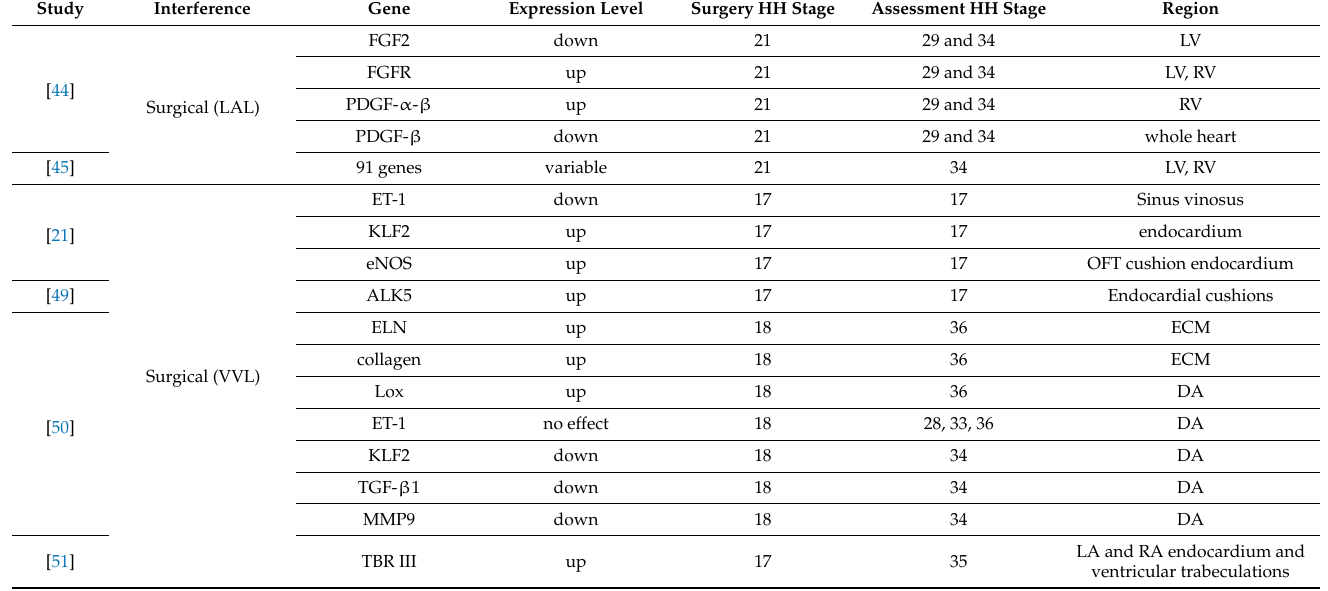
Table 1. Summary of surgical interventions and the genes they up/downregulate in the embryonic chick specific heart regions. Study Interference Gene Expression Level Surgery HH Stage Assessment HH Stage Region